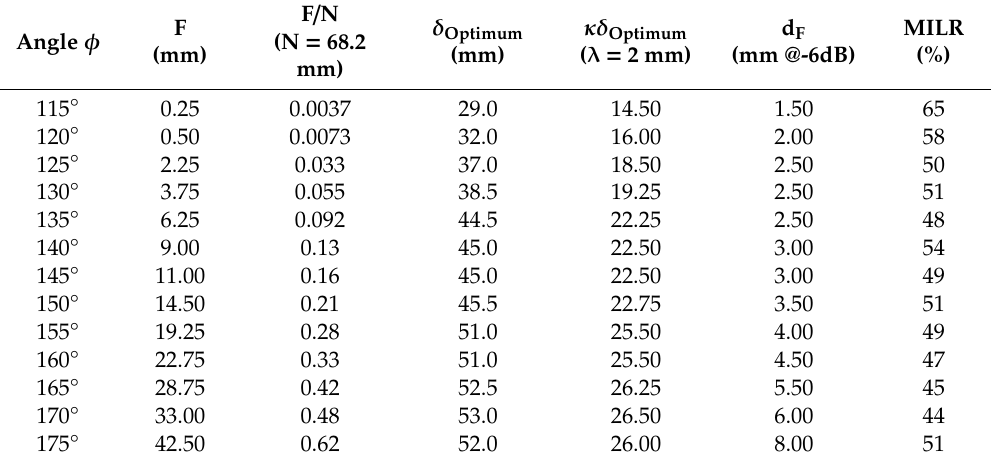
Table A2. Values, obtained by running a 512 × 512 simulation, of focal length (F), ratio of F/N, optimum stand-off ( δ Optimum ) , focus diameter (d F ), and maximum improvement of lateral resolution (MILR), for epoxy/PDMS-515 kHz ∅ 28mm axicon lens with different angles.